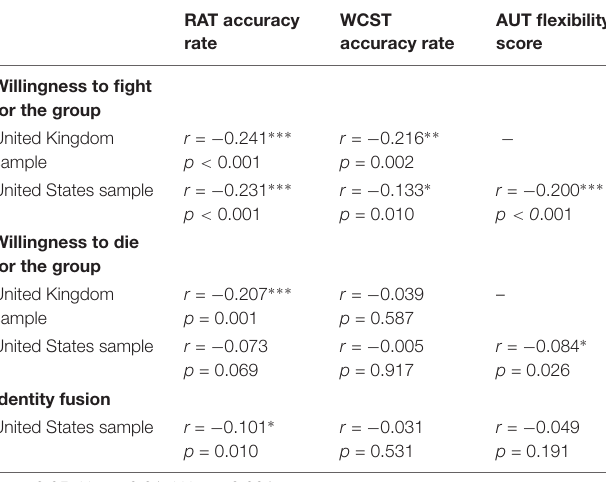
TABLE 1 | Pearson’s correlations between cognitive flexibility measures and ideological attitudes across the two